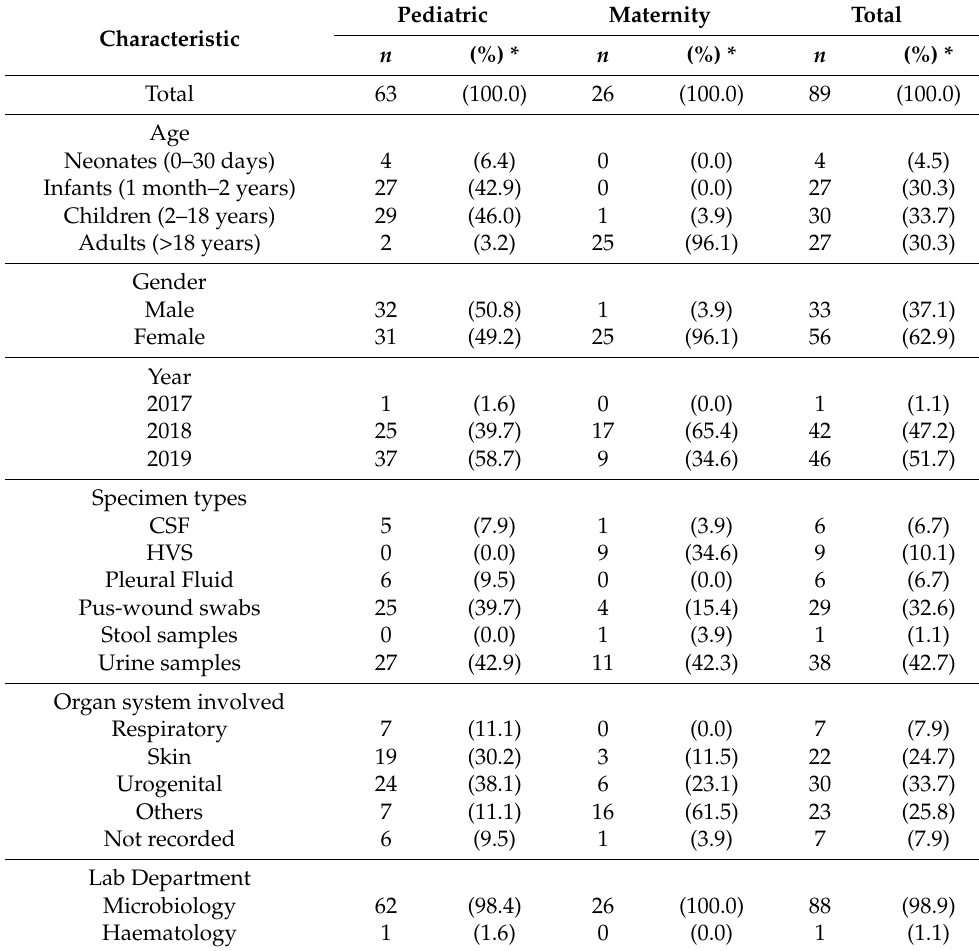
Table 1. Demographic and clinical characteristics of patients with positive bacterial isolates on cultured AST from two referral hospitals (pediatric and maternity) in Freetown, Sierra Leone from 2017 to